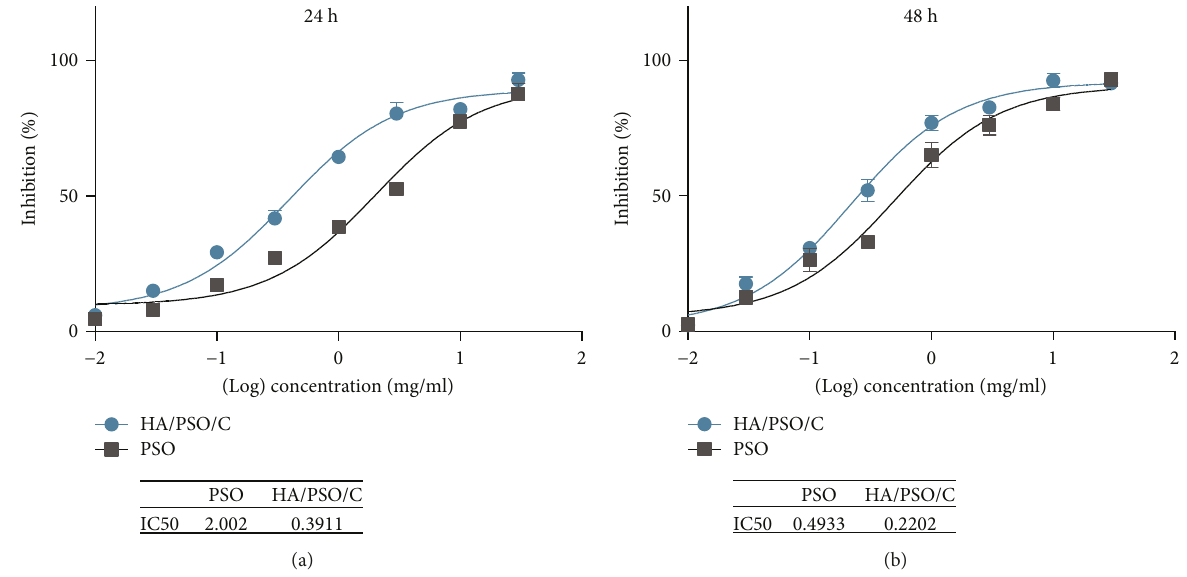
Figure 6: Enhanced cytotoxicity of PSO by nanodevices on the U251 cell. IC50 values measured for free PSO or HA/PSO/C NPs on the U251 cell at 24 h (a) and 48 h (b). Cell proliferation inhibition was measured by the MTT assay. Data are shown as means ± SD ( n = 5